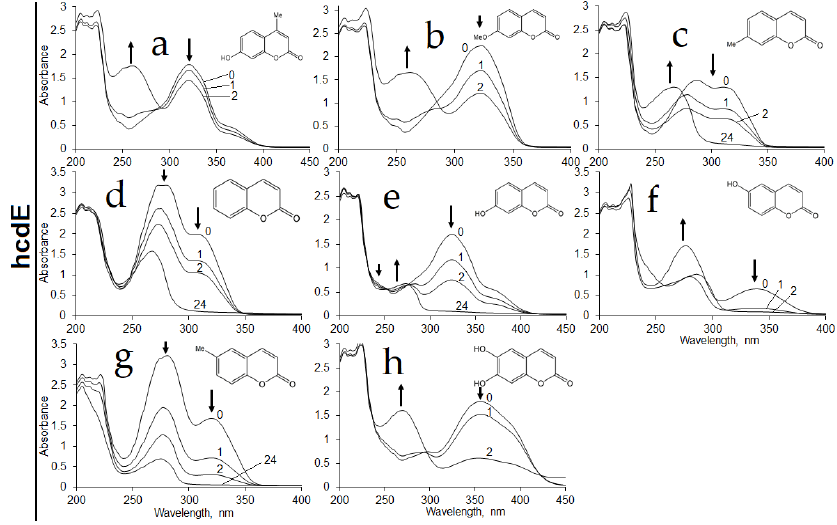
Figure 8. Biotransformation of 4-methyl-7-hydroxycoumarin ( a ), 7-methoxycoumarin ( b ), 7-methylcoumarin ( c ), coumarin ( d ), 7-hydroxycoumarin ( e ), 6-hydroxycoumarin ( f ), 6-methylcoumarin ( g ) and 6,7-dihydroxycoumarin ( h ) by whole cells of E. coli BL21 containing hcdE gene. Biotransformation was carried out in 50 mM potassium phosphate buffer pH 7.2 at 30 °C with 0.5 mM of substrate. Incubation time (hours) is shown above the curves. In several experiments ( a , b , h ), the spectra after an incubation for 24 h were omitted, due to a massive lysis of cells taking place during the prolonged incubation. Arrows indicate changes of absorbance.